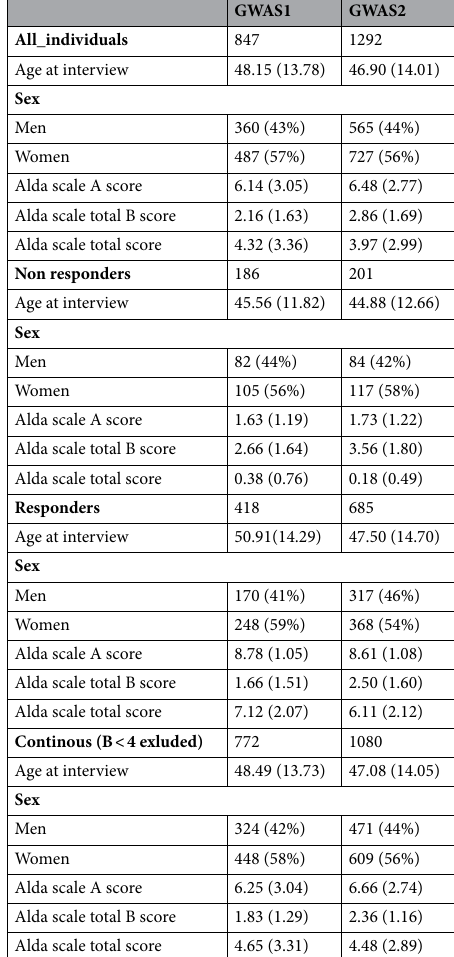
Table 1. Phenotypic characteristics of individuals used for the analyses. Data are n, n (%), or mean (SD). Alda scale refers to the Retrospective Criteria of Long-Term Treatment Response in Research Subjects with Bipolar Disorder; Non-resp = Li non responders (ALDA subscale A less than or equal to 3); Resp = Li responders (ALDA subscale A greater than or equal to 7).